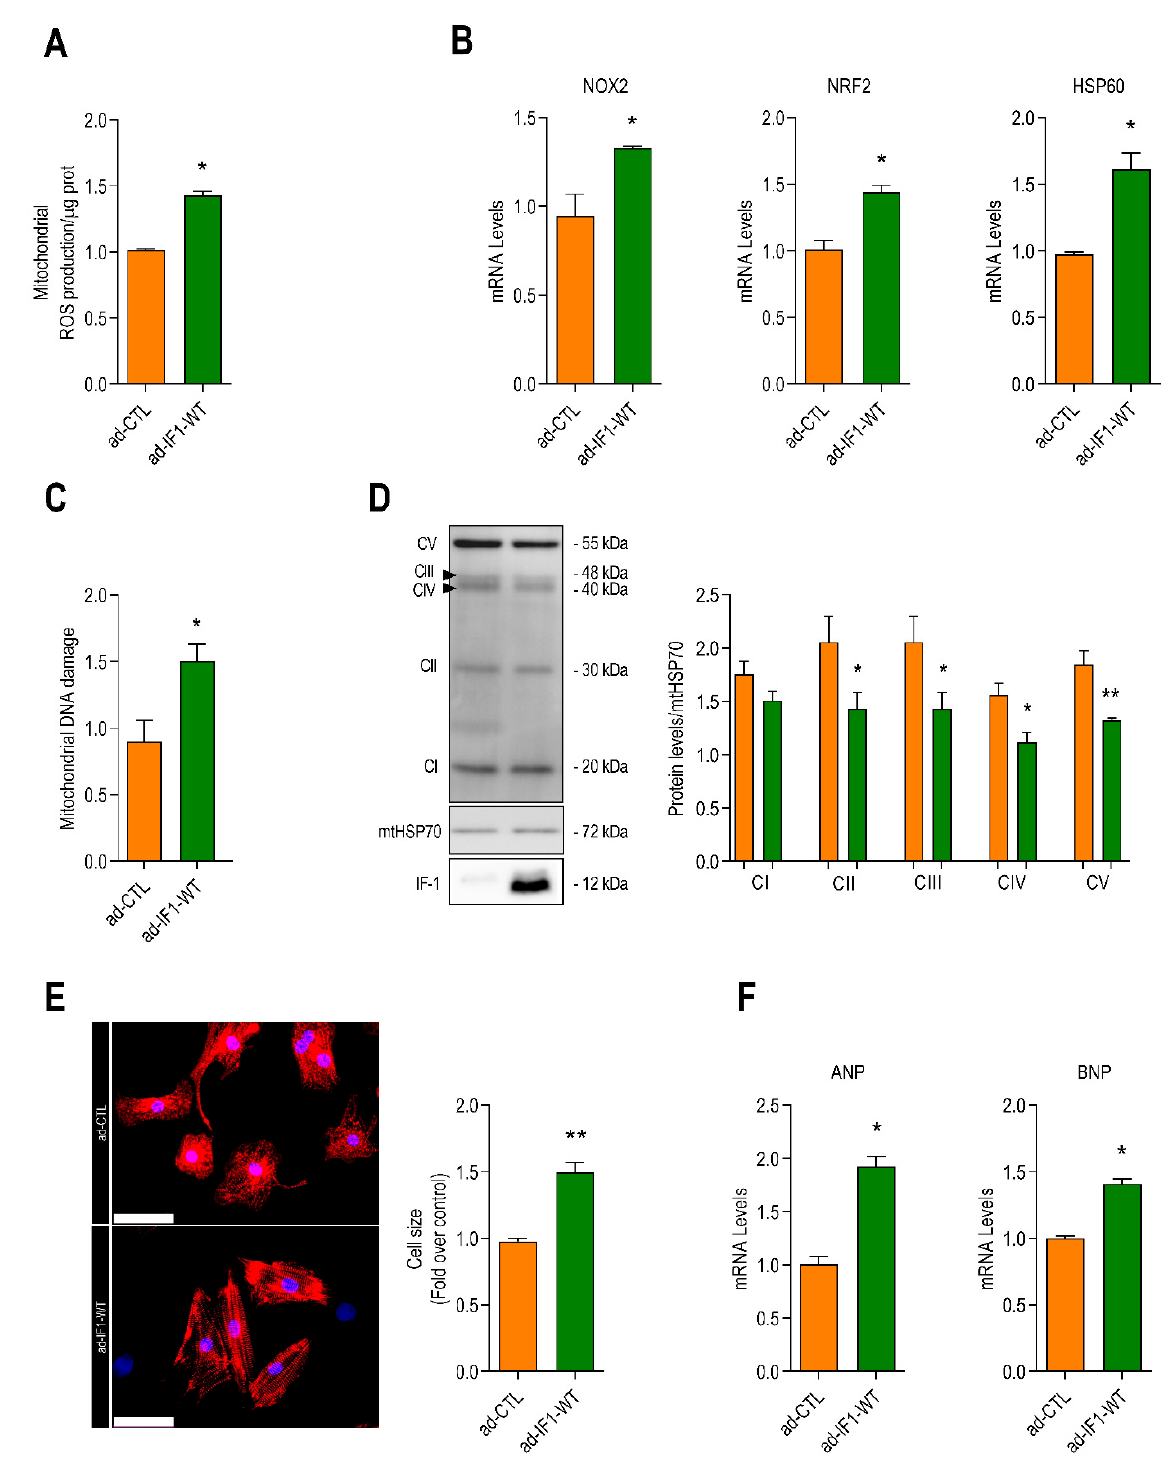
Figure 2. IF1 overexpression promotes mitochondrial reactive oxygen species (ROS) production and cardiomyocyte hypertrophy. NRVMs were infected with an adenoviral vector expressing the human IF1 (ad-IF1-WT) or a control virus (ad-CTL) for 48 h. All bar graphs depict the results of at least three independent experiments. ( A ) Basal mitochondrial ROS emissions detected with the mitochondrial ROS sensor MitoSOX ® ( n = 4). ( B ) mRNA expression of the mitochondrial ROS-sensitive genes NADPH oxidase 2 ( NOX2 ), nuclear receptor factor-2 ( NRF2 ), and heat shock protein-60 ( HSP60 ) ( n = 4). ( C ) Semi-log-run polymerase chain reaction was performed using specific primers for mitochondrial DNA fragments in the mitochondrial D-Loop region to determine oxidative damage to mitochondrial DNA ( n = 4). ( D ) Changes in the protein levels of mitochondrial respiratory chain complexes in cells infected with ad-IF1-WT and ad-CTL detected by Western